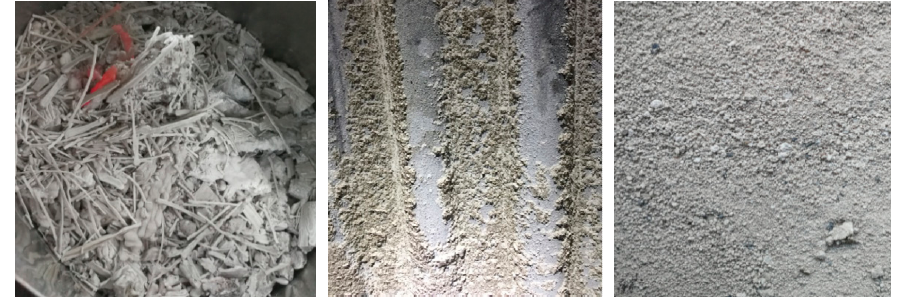
Figure 13. Form of alkali ash collected in different parts of the incinerator.